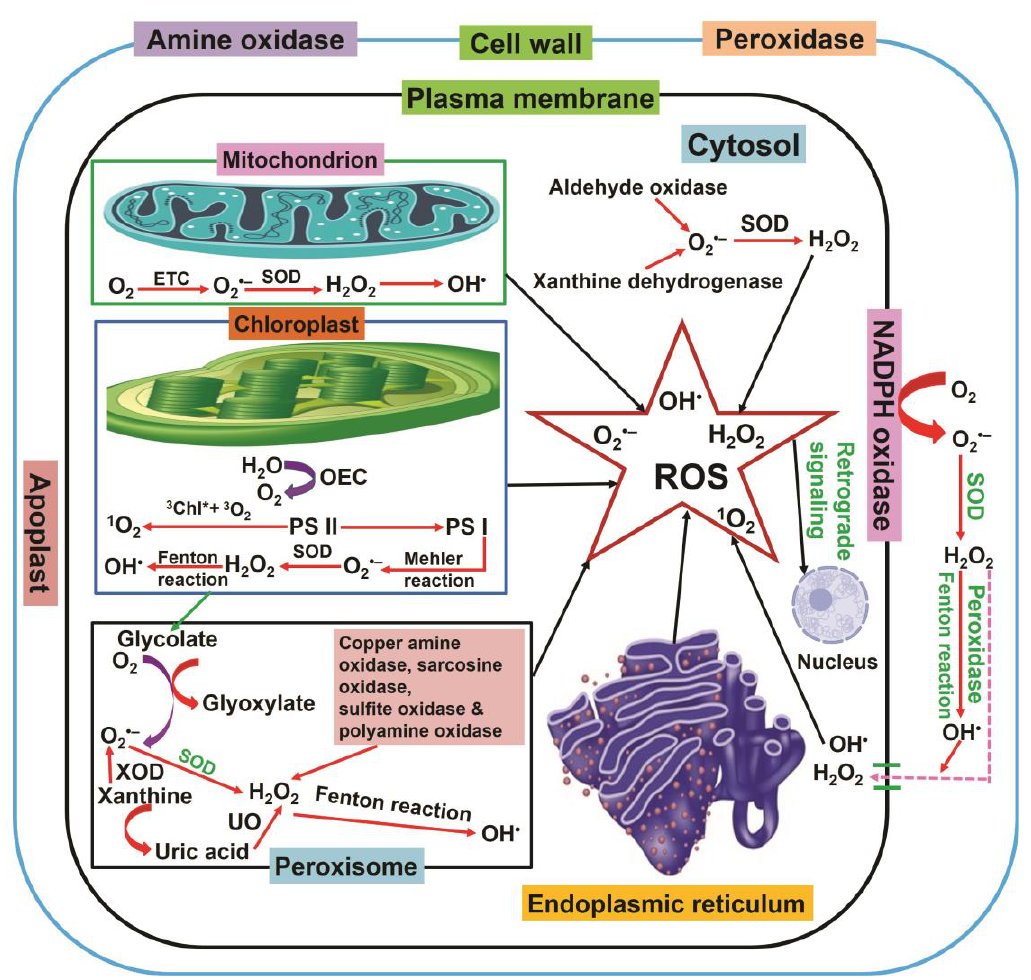
Figure 2. Mechanism and site of production of ROS in plants. SOD, superoxide dismutase; ROS, reactive oxygen species; ETC, electron transport chain; OEC, oxygen-evolving center; H 2 O 2 , hydrogen peroxide; PS I, photosystem I; PS II, photosystem II; O 2 − • , superoxide anion; 1 O 2 , singlet